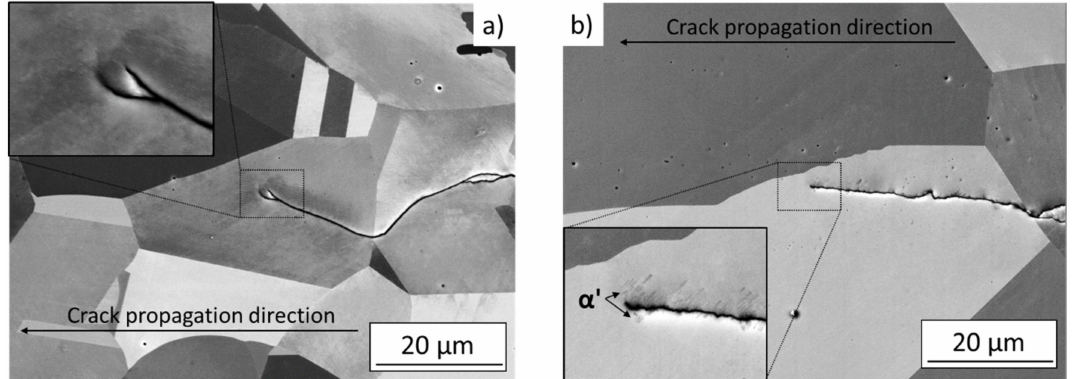
Figure 10. SEM images of the crack tip area after the crack arrest at threshold, R = 0.7, 150 ◦ C; ( a ) as-received state, ( b ) solution-annealed